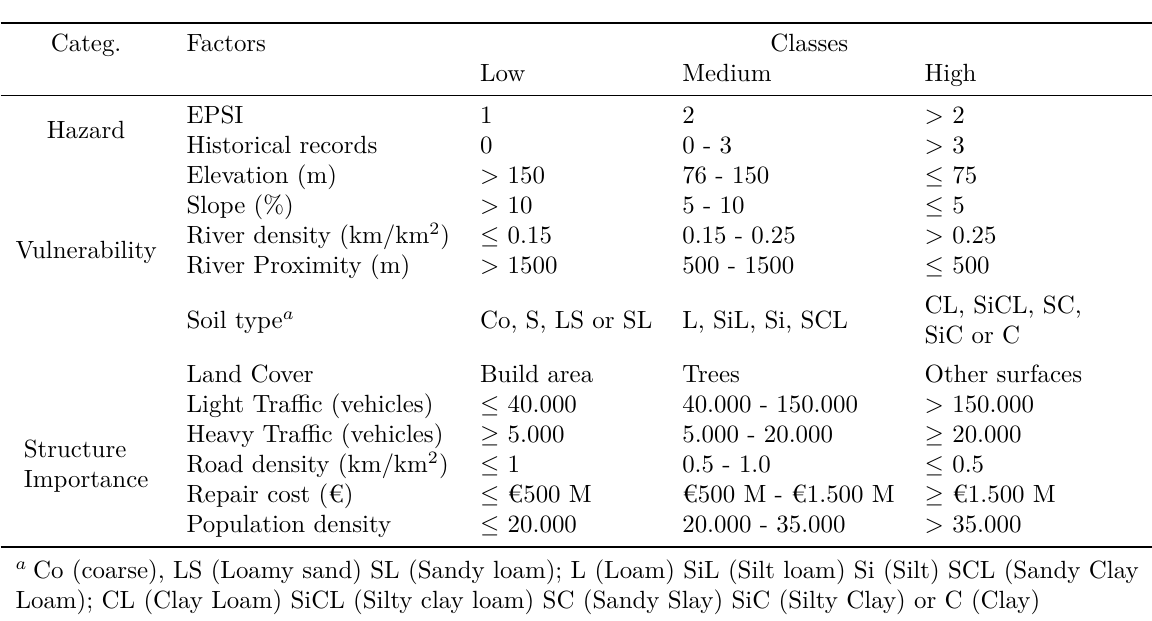
Table 1. Classification of different risk factors.